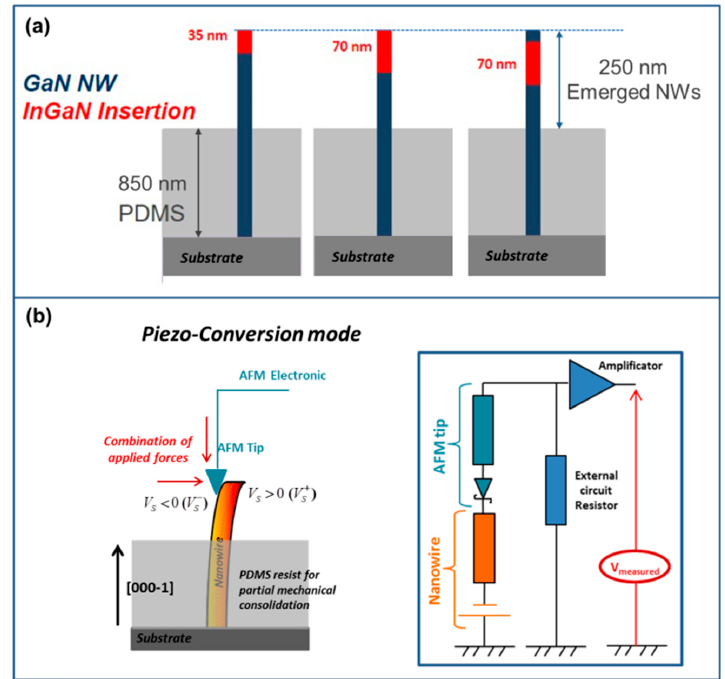
Figure 2. ( a ) Schematization of the investigated structures: GaN NW base with an InGaN insertion localized on the top. From left to right: uncapped 35 ± 5 nm thick InGaN section; uncapped 70 ± 9 nm thick InGaN section and capped 70 ± 9 nm thick InGaN section. ( b ) Schematic representation of the piezo-generation measurement principle on single NWs, using an atomic force microscope (AFM) system in vertical configuration equipped with a modified Resiscope module. To perform accurate piezo-conversion measurements under AFM, the NWs have been mechanically consolidated with an 850 nm thick PDMS matrix, the emerged NW height being of the order of 250 nm. In order to measure accurately the piezoelectric response of individual NWs (with the AFM system described below) and because the III-N NWs are characterized by a high flexibility, the NWs have been mechanically consolidated by embedding their bottom portion in an 850 nm thick polydimethylsiloxane (PDMS) layer (Figure 2a). This flexible matrix allows ensuring the mechanical consolidation of the NWs without applying to them any deformation or strain (as verified by Raman spectroscopy measurements non-presented here). The height of the emerging NW portions is of about 250 ± 100 nm, while the density of the NWs remains unchanged.